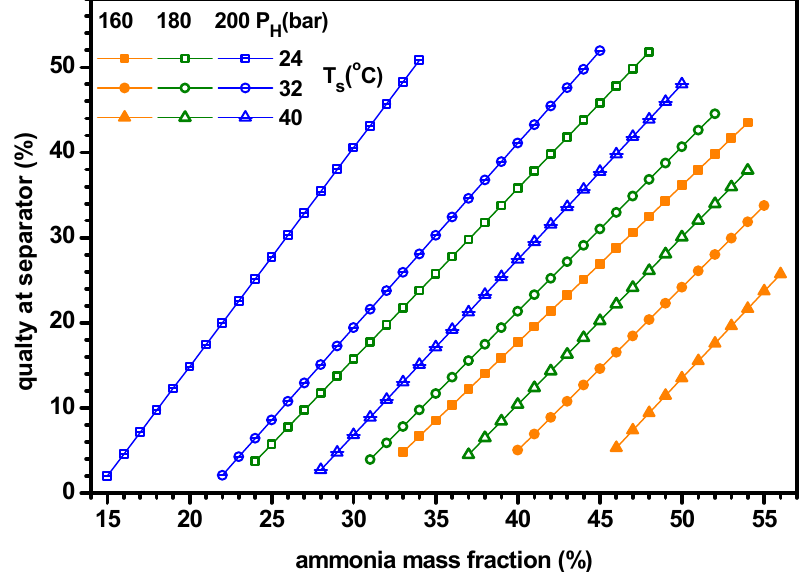
Figure 5. Quality at separator for varying ammonia fraction.